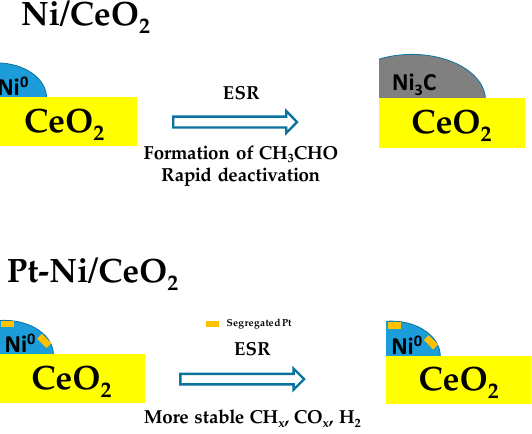
Figure 7. E ff ect of Pt addition on carbon formation for Pt / CeO 2 catalysts Figure 7. Effect of Pt addition on carbon formation for Pt/CeO 2 catalysts [84].